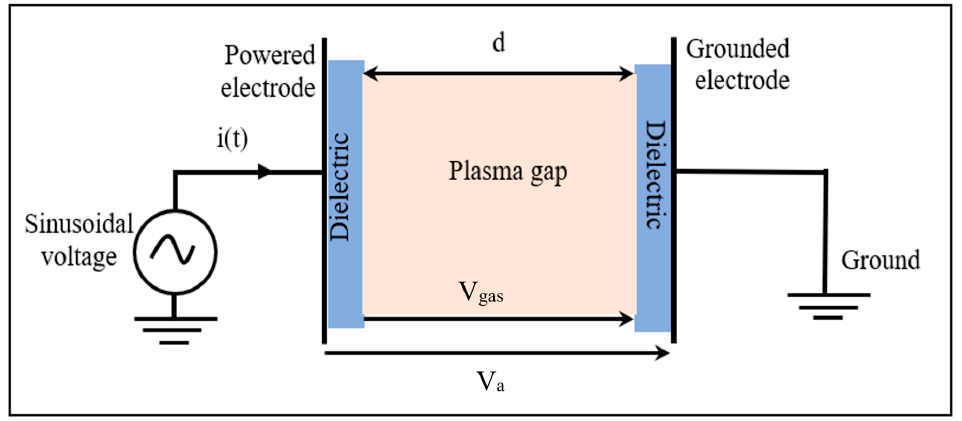
Figure 2. Schematic diagram of the DBD plasma gap.